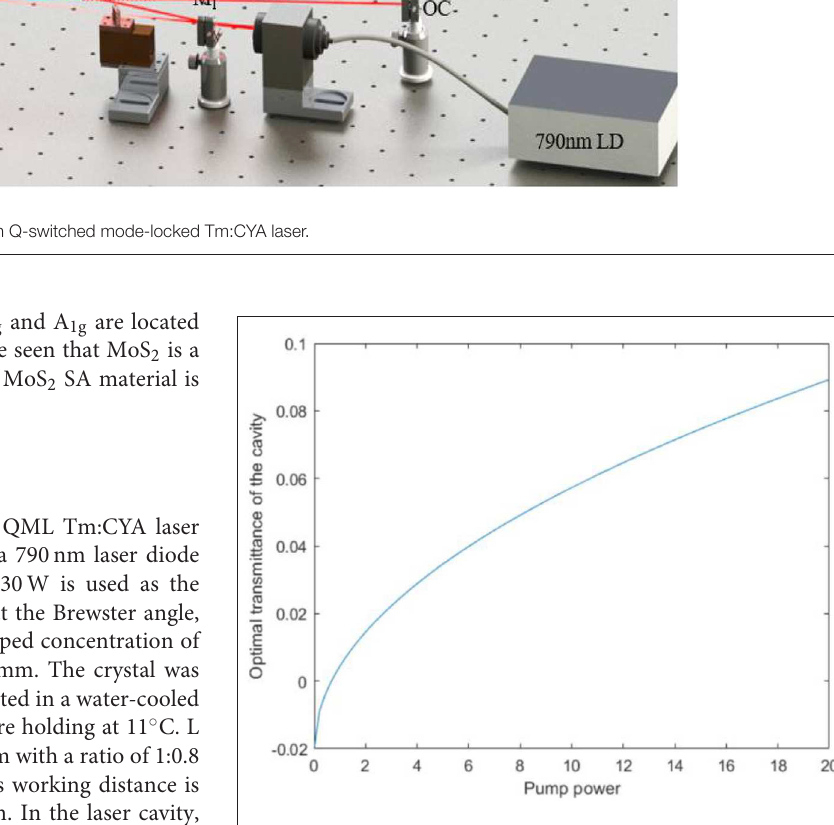
FIGURE 3 | Optimal cavity transmissivity vs. pump